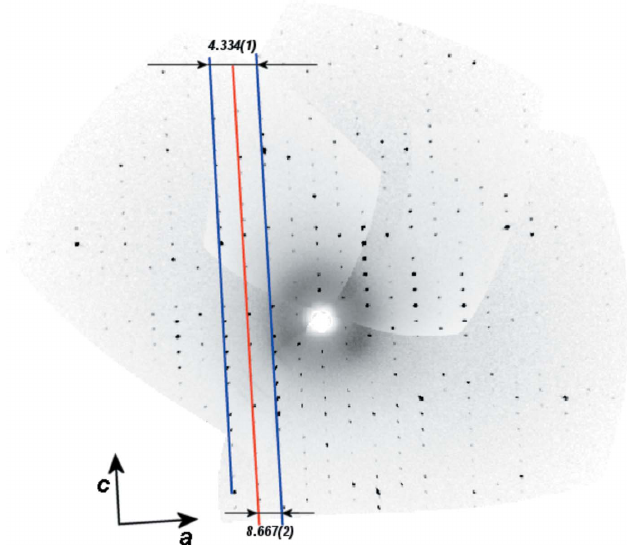
Figure 2 The revised crystal structure of trans -resveratrol involved a doubling of one of the unit-cell dimensions. There were weaker interleaving layer lines that were missed in the original analysis and the correct unit cell was established in the re-analysis. For details, see the text. Reproduced with the permission of the authors (Zarychta et al. , 2016) and the journal Bioorganic and Medicinal Chemistry Letters